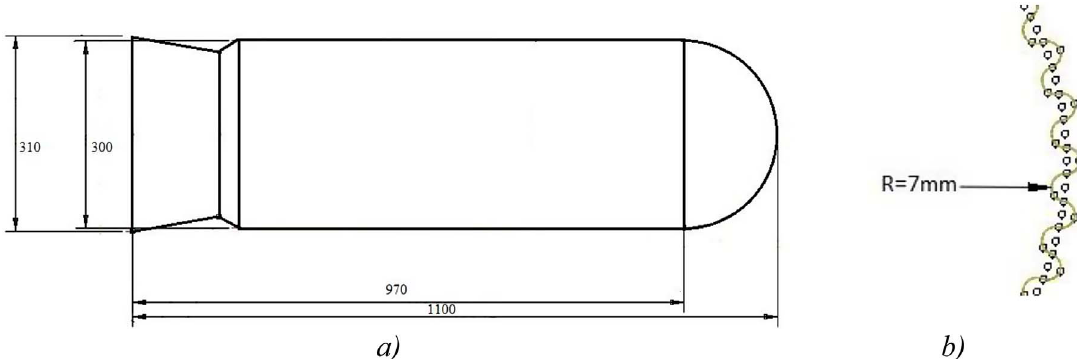
Figure 1. Dimensions of the considered system, (a) combustion chamber and (b) baf fl